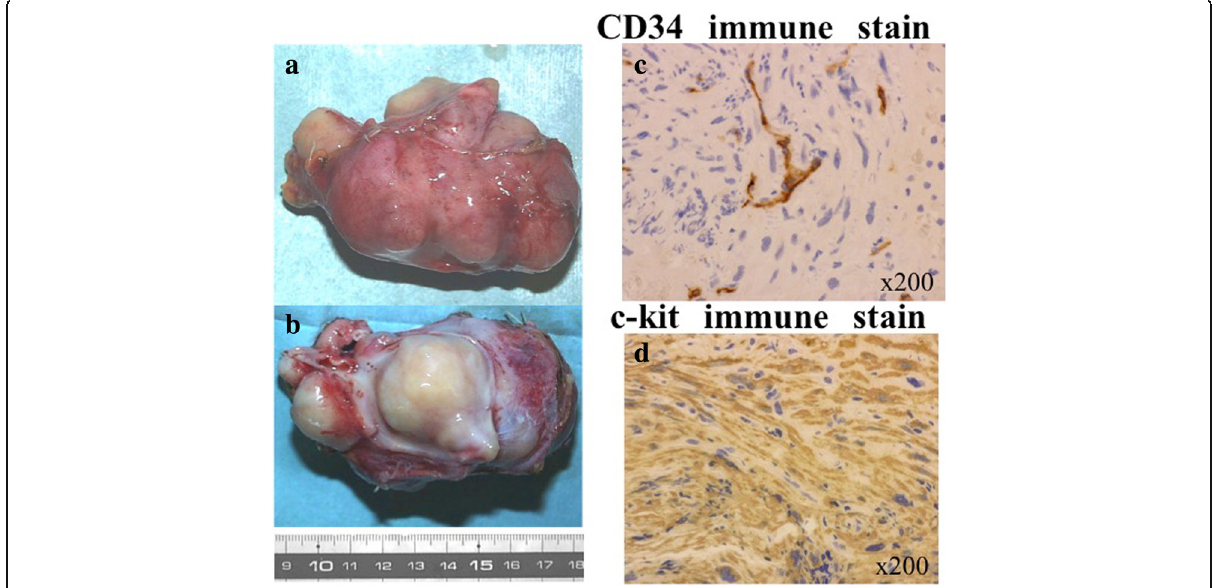
Fig. 6 Gross pathology and immunohistochemical findings. A well-circumscribed and pseudo-capsulated white yellowish elastic mass ( a ), contin- ued with the IVC wall, was observed to have a smooth intraluminal caval surface ( b ). Immunohistochemical staining demonstrated the tumor cells to be positive for CD34 ( c ) and c-kit ( d ) expression. IVC inferior vena